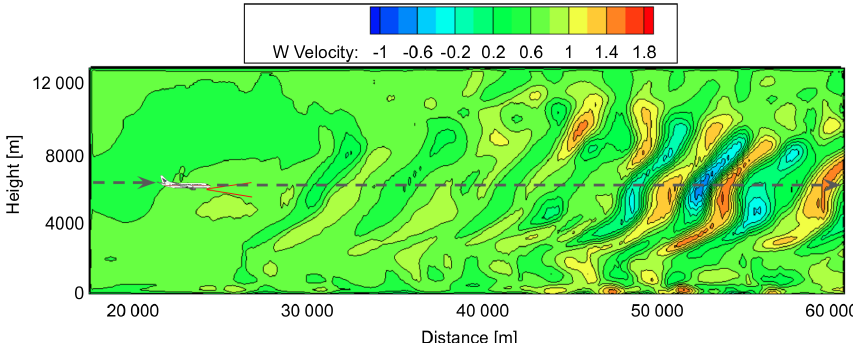
Figure 9. Vertical wind-velocity distribution map generated by JMA-NHM.